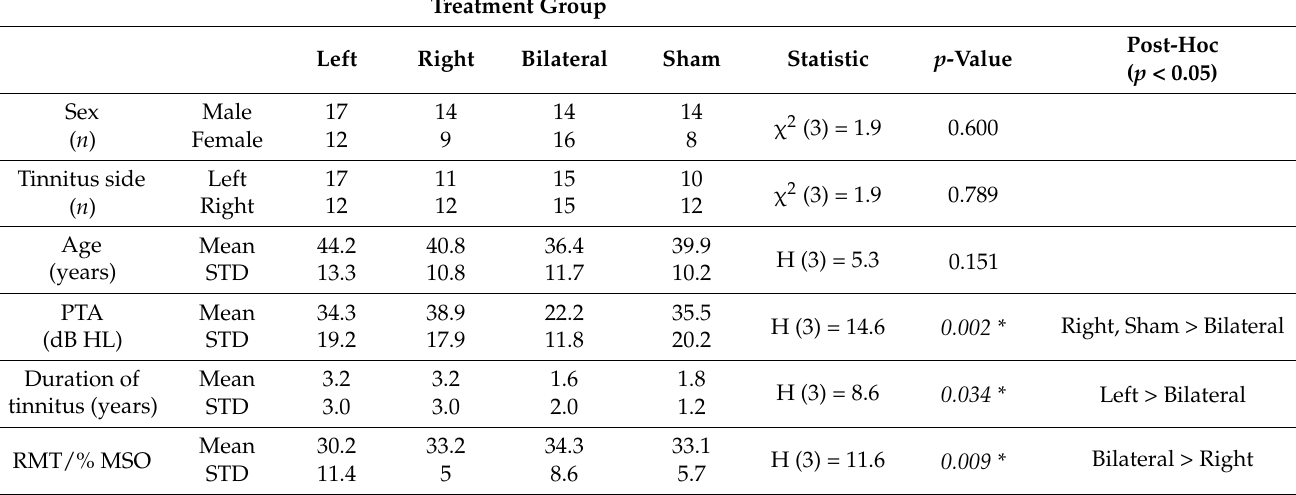
Table 1. Demographic information for tinnitus patients within each treatment group. Statistical analyses are shown at right. Chi-square tests were performed to compare the distributions of participant sex and tinnitus side across treatment groups. Kruskal–Wallis one-way ANOVAs were performed on ranked data to compare the distributions of age at testing, pure-tone average (PTA) thresholds in decibels hearing level (dB HL), duration of tinnitus in years, and resting motor threshold (RMT) in percent of maximum stimulator output (% MSO) across treatment groups. Significant differences according to post-hoc Dunn’s tests are shown on the far right. STD = standard deviation. Treatment Group Right Bilateral Sham Statistic p -Value